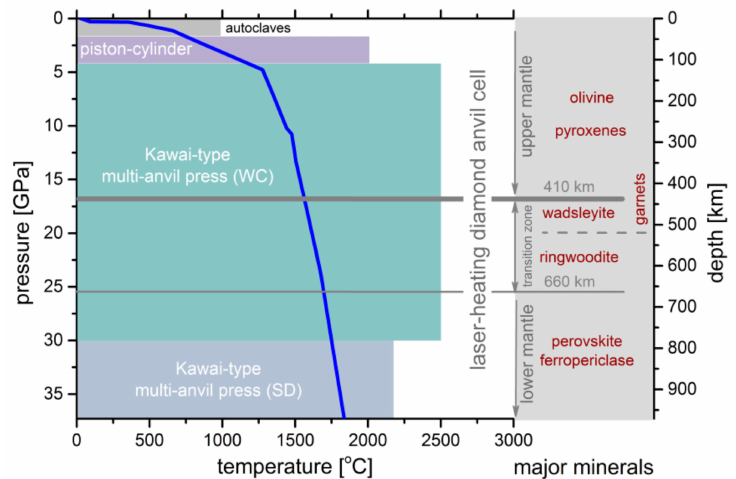
Figure 2. The pressure and temperature ranges of di ff erent types of apparatuses (denoted with di ff erent colors) in a T-P profile of the Earth (blue line), according to the Preliminary Reference Earth Model (PREM) [55]. The major minerals of the mantle up to the depth of 900 km have been